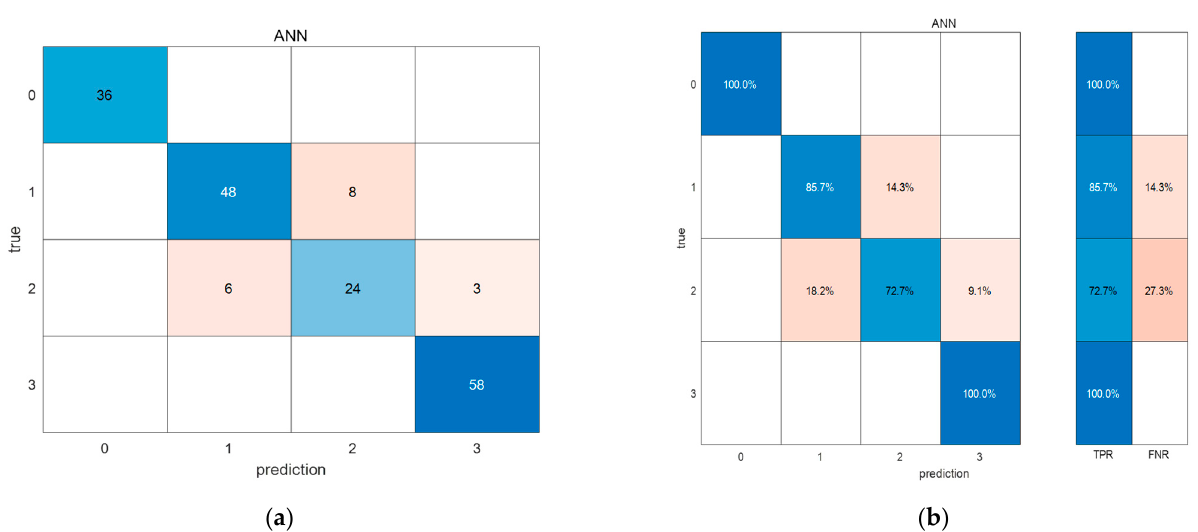
Figure 9. The confounding matrix of the ANN model. Confounding matrix of quantity ( a ) and confounding matrix of percentage ( b ). confounding matrix of percentage ( b